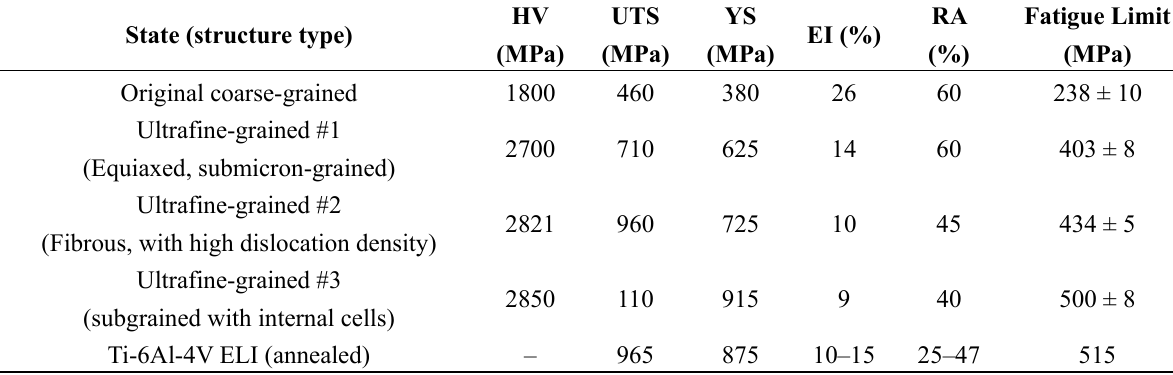
Table 8. Microhardness, tensile mechanical properties and fatigue limit of grade 2 CP Ti in different states [140]. Reprinted with permission from [140]. Copyright 2006 Elsevier.